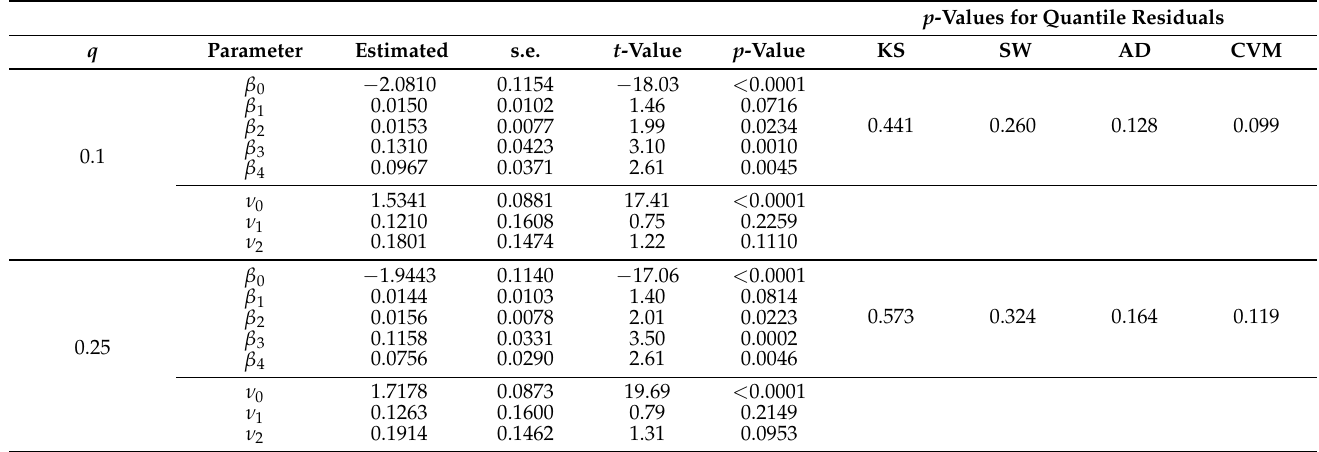
Table A3. The estimated parameters for different quantiles in the RPGJSB2 q model of the COVID-19 data set, with the normal distribution for G and the loglog link. Furthermore, we present the p -values for the traditional normality test for the randomized quantile